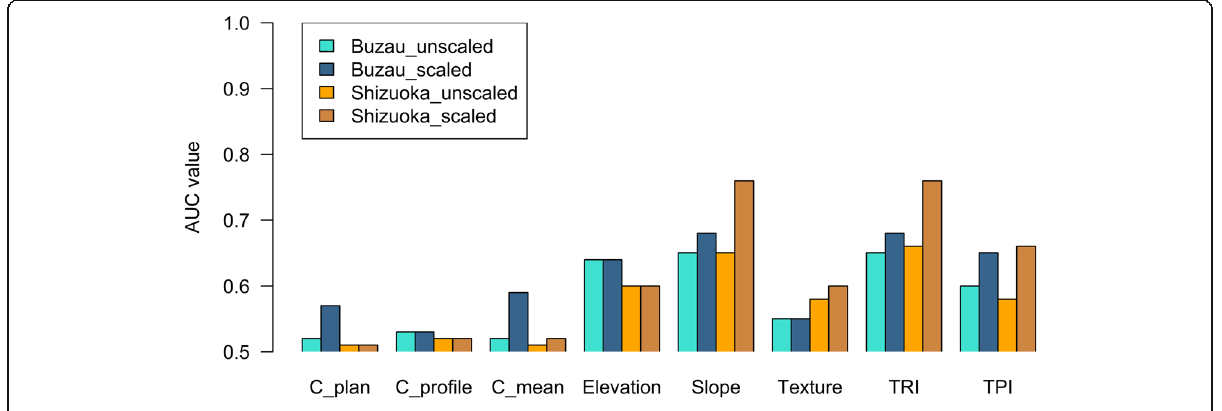
Fig. 6 AUC results for landslide scarps modeling with individual predictors